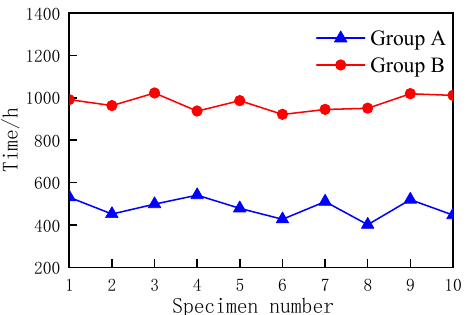
Figure 3. SEM of MOCRC. ( a ) Group A. ( b ) Group B.